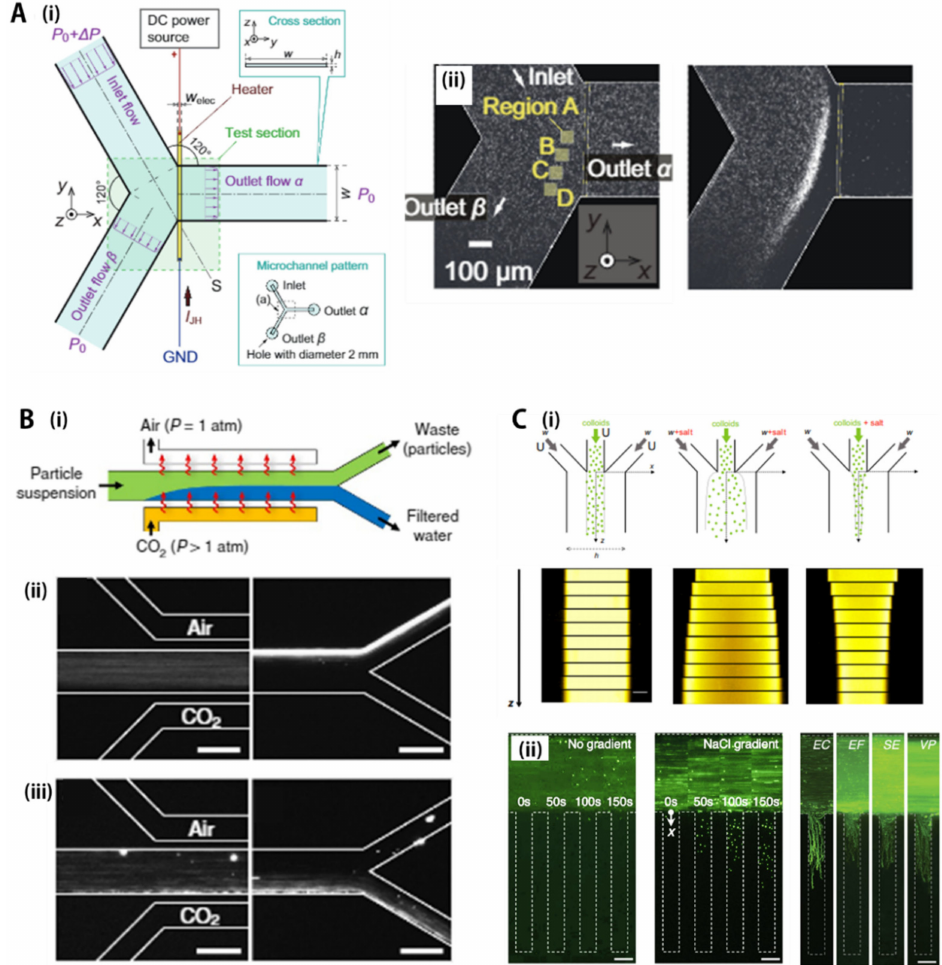
Figure 3. Microfluidic passive-force separation group 2: environmental gradient-based separation. ( A ) ( i ) Illustration to show generation of thermal gradients in microchannel using Joule heating. ( ii ) Separation of particles using thermal gradient, called thermophoresis. Particles separated toward out- let α or β according to their thermophoretic responses. Reprinted with permission from MDPI [101]; ( B ) ( i ) Illustration to describe creation of gas (CO 2 ) concentration gradient using air-permeable PDMS microchannel. ( ii ) Separation results using gas concentration gradient. Anionic particles migrated toward high CO 2 concentration wall, while cation particles were repelled from the high-concentration zone. Reprinted with permission from the Nature Publishing Group [107]; ( C ) ( i ) Particle migration using salt concentration gradient with various operation modes. Reprinted with permission from IOP Publishing Ltd. [108]. ( ii ) Bacterial separation using diffusiophoresis. Negatively charged bacterial cells moved toward high salt concentration channel by salt concentration gradient. Reprinted with permission from the American Chemical Society [109]. All rights